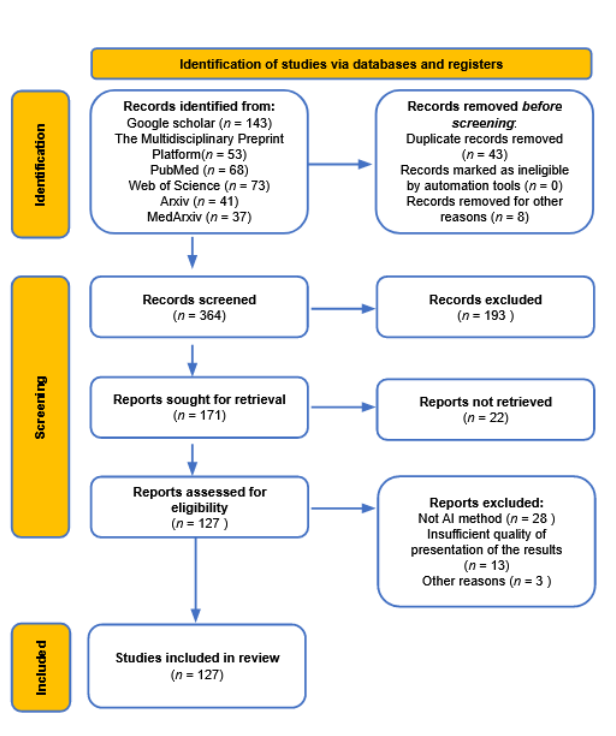
Figure 1. Visualization of the reviewing procedure using PRISMA